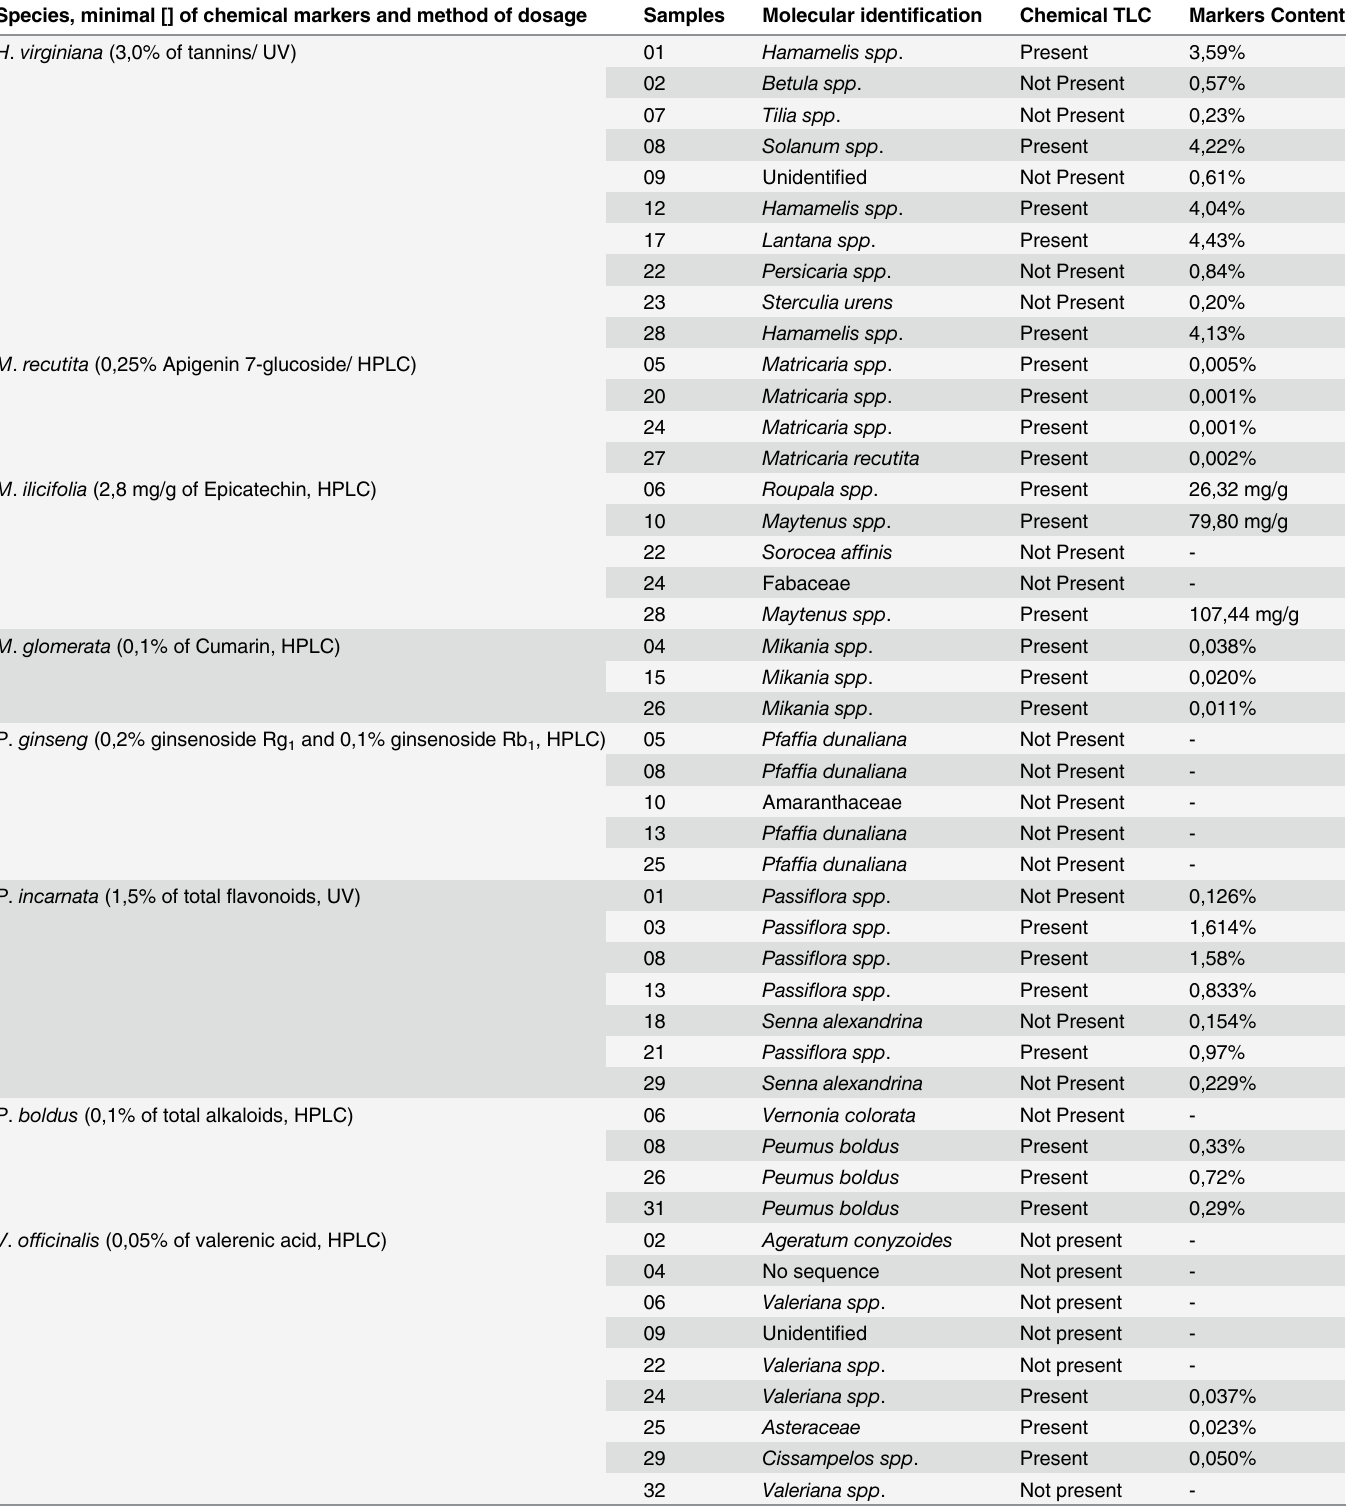
Table 4. Molecular identification versus TLC, HPLC and UV analyses. Species, minimal [] of chemical markers and method of